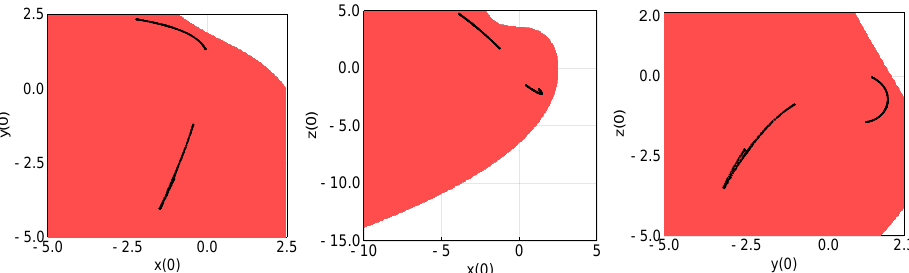
Figure 4. Cross sections of the basin of attraction of the chaotic attractor in the planes: z ( 0 ) = 0 ( left ); Figure 7. Various hidden attractors of system (1) with parameters α = 2.9, β = 1 and different a , y ( 0 ) = 0 ( center ); x ( 0 ) = 0 ( right ). Initial conditions in the white regions lead to unbounded orbits, where the upper pannel plots the phase portraits of the hidden attractors projected in the x and those in the red regions lead to the chaotic plane, the lower pannel shows the local basins of attraction and the crossing trjectories of the hidden attractors. (a) and (e) hidden period-1 limit cycle for a = 0.985; (b) and (f) hidden period-2 limit cycle for a = 0.994; (c) and (g) hidden period-4 limit cycle for a = 0.9955; (d) and (h) hidden chaotic attractor for a = 0.997.